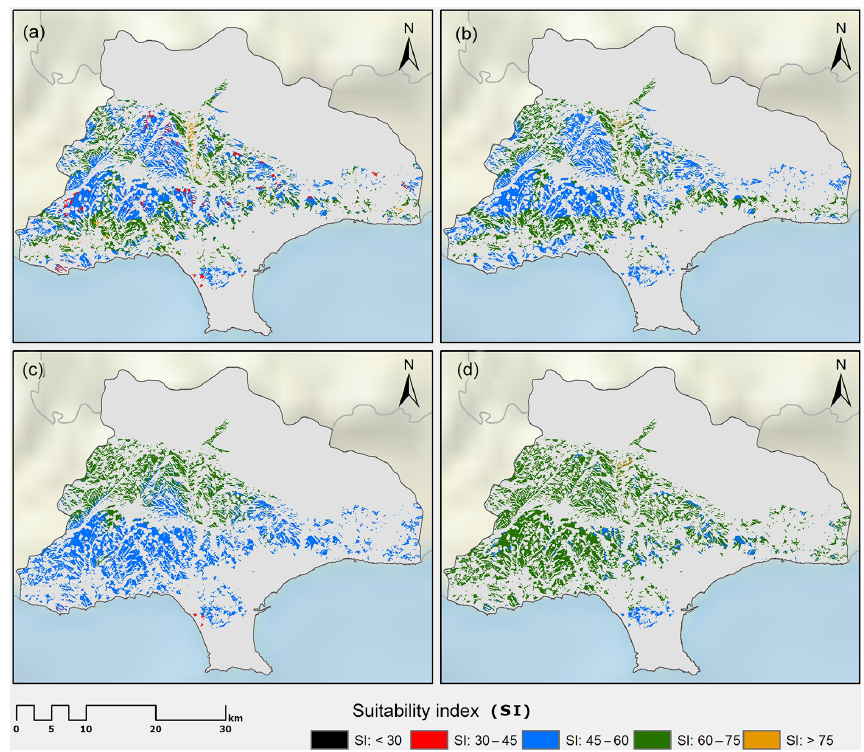
Figure 7. Classified results of sensitivity analysis and comparison among different scenarios: (a) case 1, (b) case 2, (c) case 3, and (d) case 4.